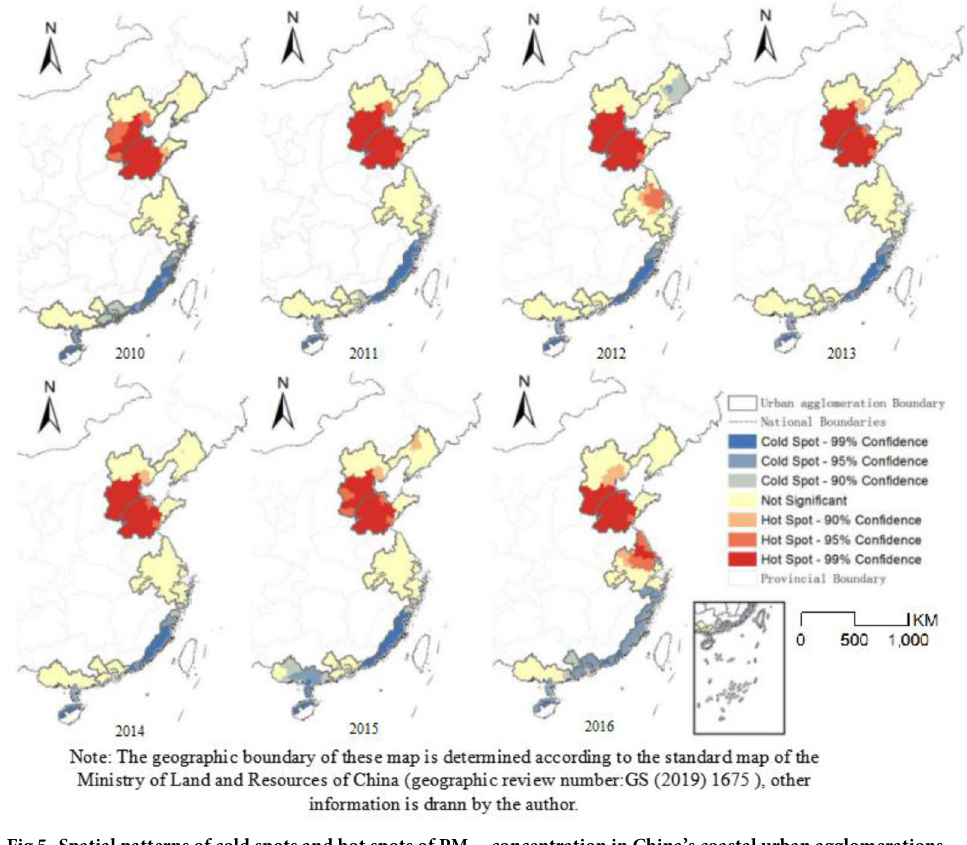
Fig 5. Spatial patterns of cold spots and hot spots of PM 2.5 concentration in China’s coastal urban agglomerations from 2010–2016.